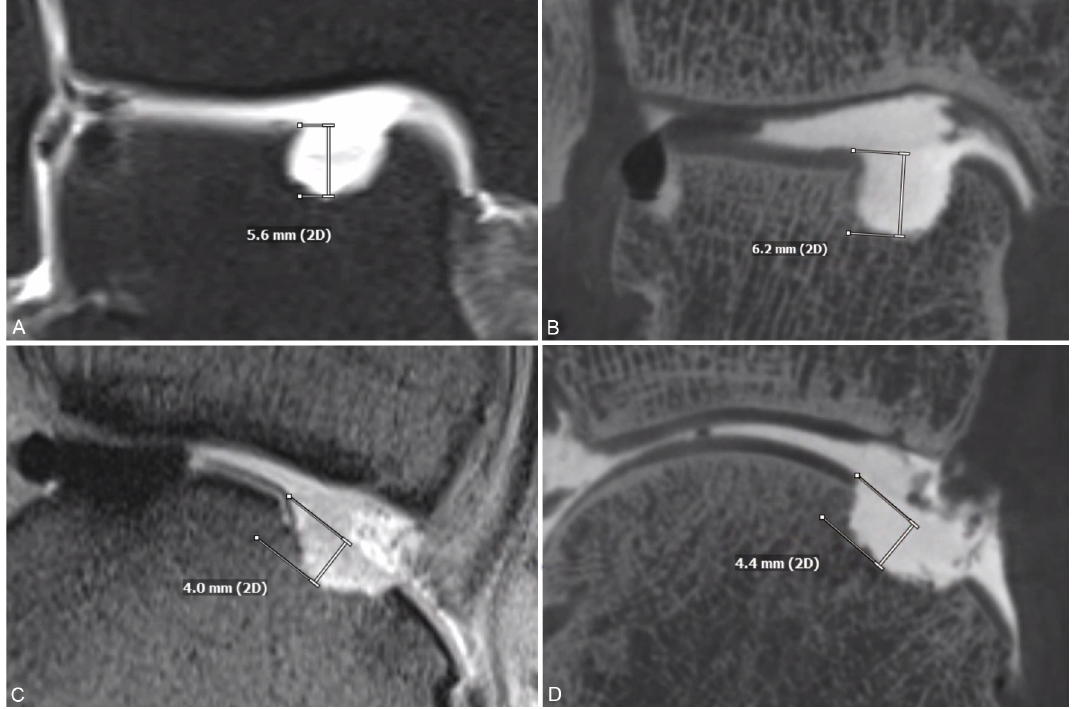
Fig 4. Different MR sequences and flat panel CT-arthrography measurements. Proton density weighted (PDw) coronal (A) and T1w sagittal (C) magnetic resonance arthrography (MR-A) sequences and the correspondingly reconstructed plane in FPCT-A images (B and D) of the same artificial defect. The marked depth measurements show larger values for the FPCT-A images.